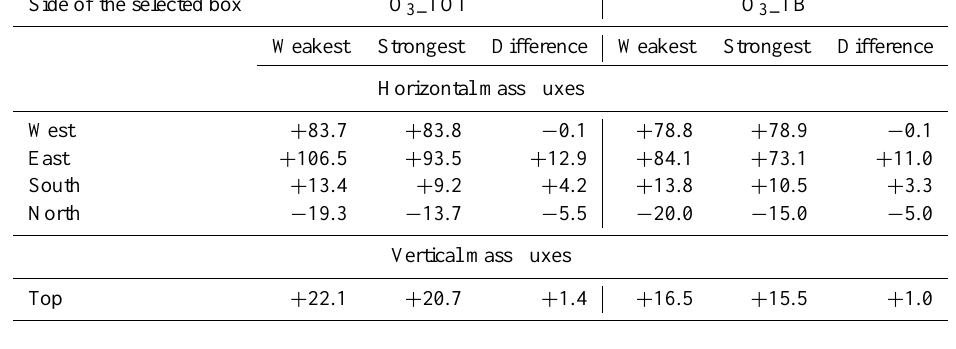
Table 1. The composite analyses of horizontal and vertical fluxes of O 3 (Tgseason − 1 ) for the selected box (85–120 ◦ E, 20–46 ◦ N, from the surface to 250hPa) based on simulations O 3 _TOT and O 3 _TB. The values are averaged over the five weakest (1988, 1989, 1996, 1998, and 2003) and five strongest monsoon years (1990, 1994, 1997, 2002, and 2006), and the differences are calculated as (weakest–strongest). For horizontal fluxes, positive values indicate eastward or northward transport and negative values indicate westward or southward transport. For vertical fluxes, positive values indicate upward transport.